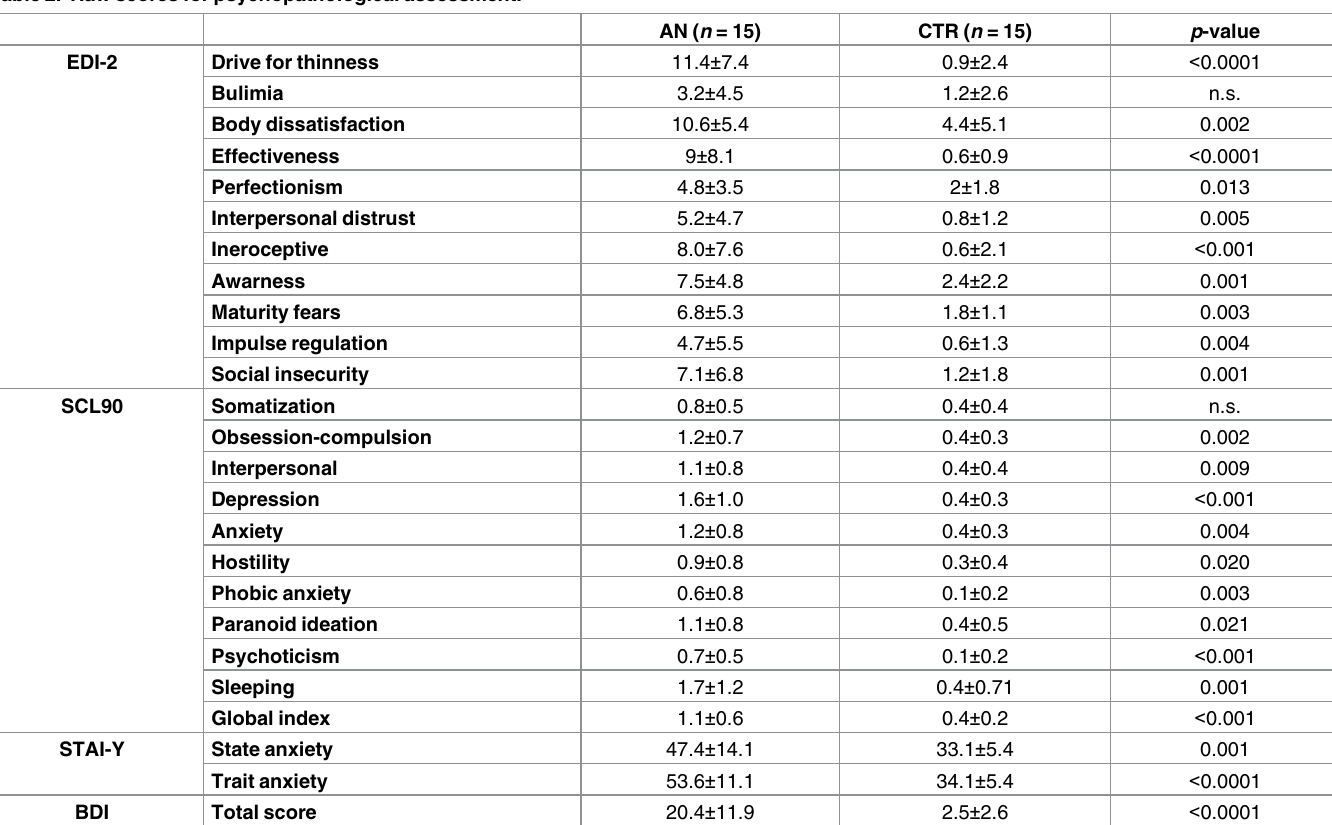
Table 2. Raw scores for psychopathological